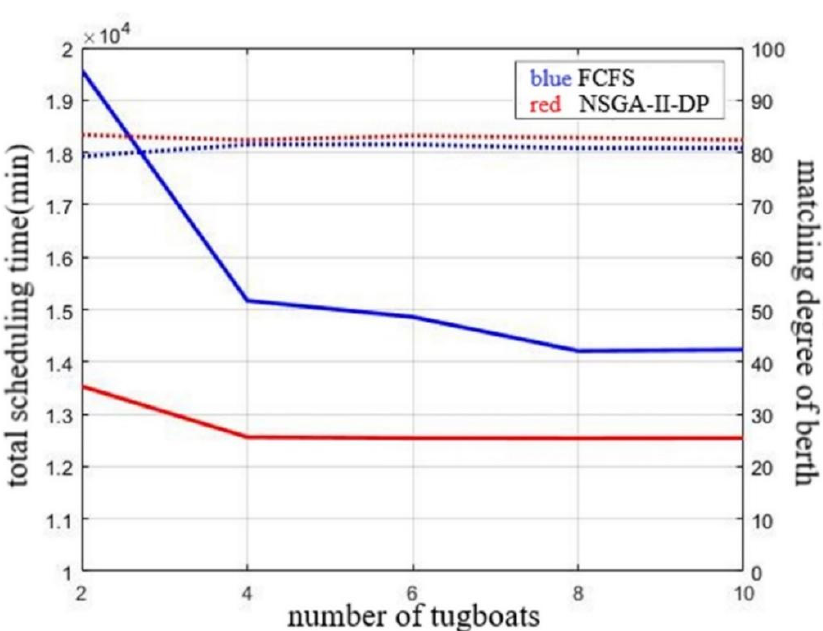
Figure 13. Comparison between the results of the total vessel scheduling time and the berth matching degree obtained using the traditional FCFS strategy and those obtained using the NSGA-II-DP algorithm for different numbers of tugs.